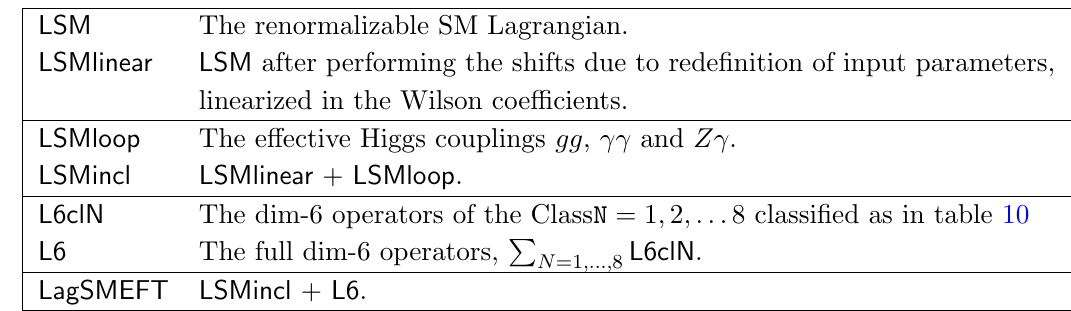
Table 3 . Lagrangian terms de(cid:12)ned in the SMEFTsim